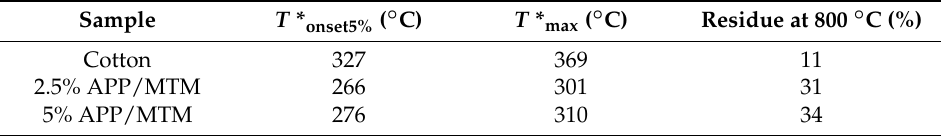
Figure 2. Thermogravimetric (TG) and derivative (dTG) curves of untreated and treated cotton fabrics in nitrogen. Table 1. Thermogravimetric data of untreated and treated samples in nitrogen.